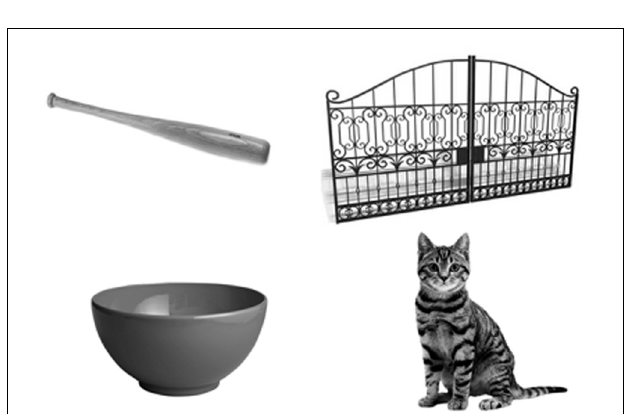
FIGURE 1 | Schematic for the four-alternative forced choice task, where the circle represents the participant’s position in relation to the touchscreen and speakers (represented by the gray boxes). Each speaker is positioned 43 inches away from the participant.